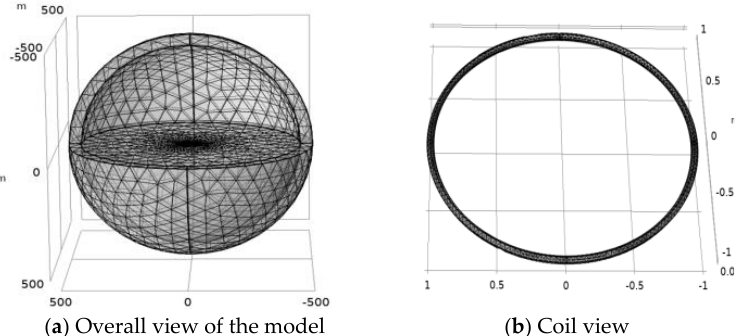
Figure 4. Results of non-uniform grid subdivision.